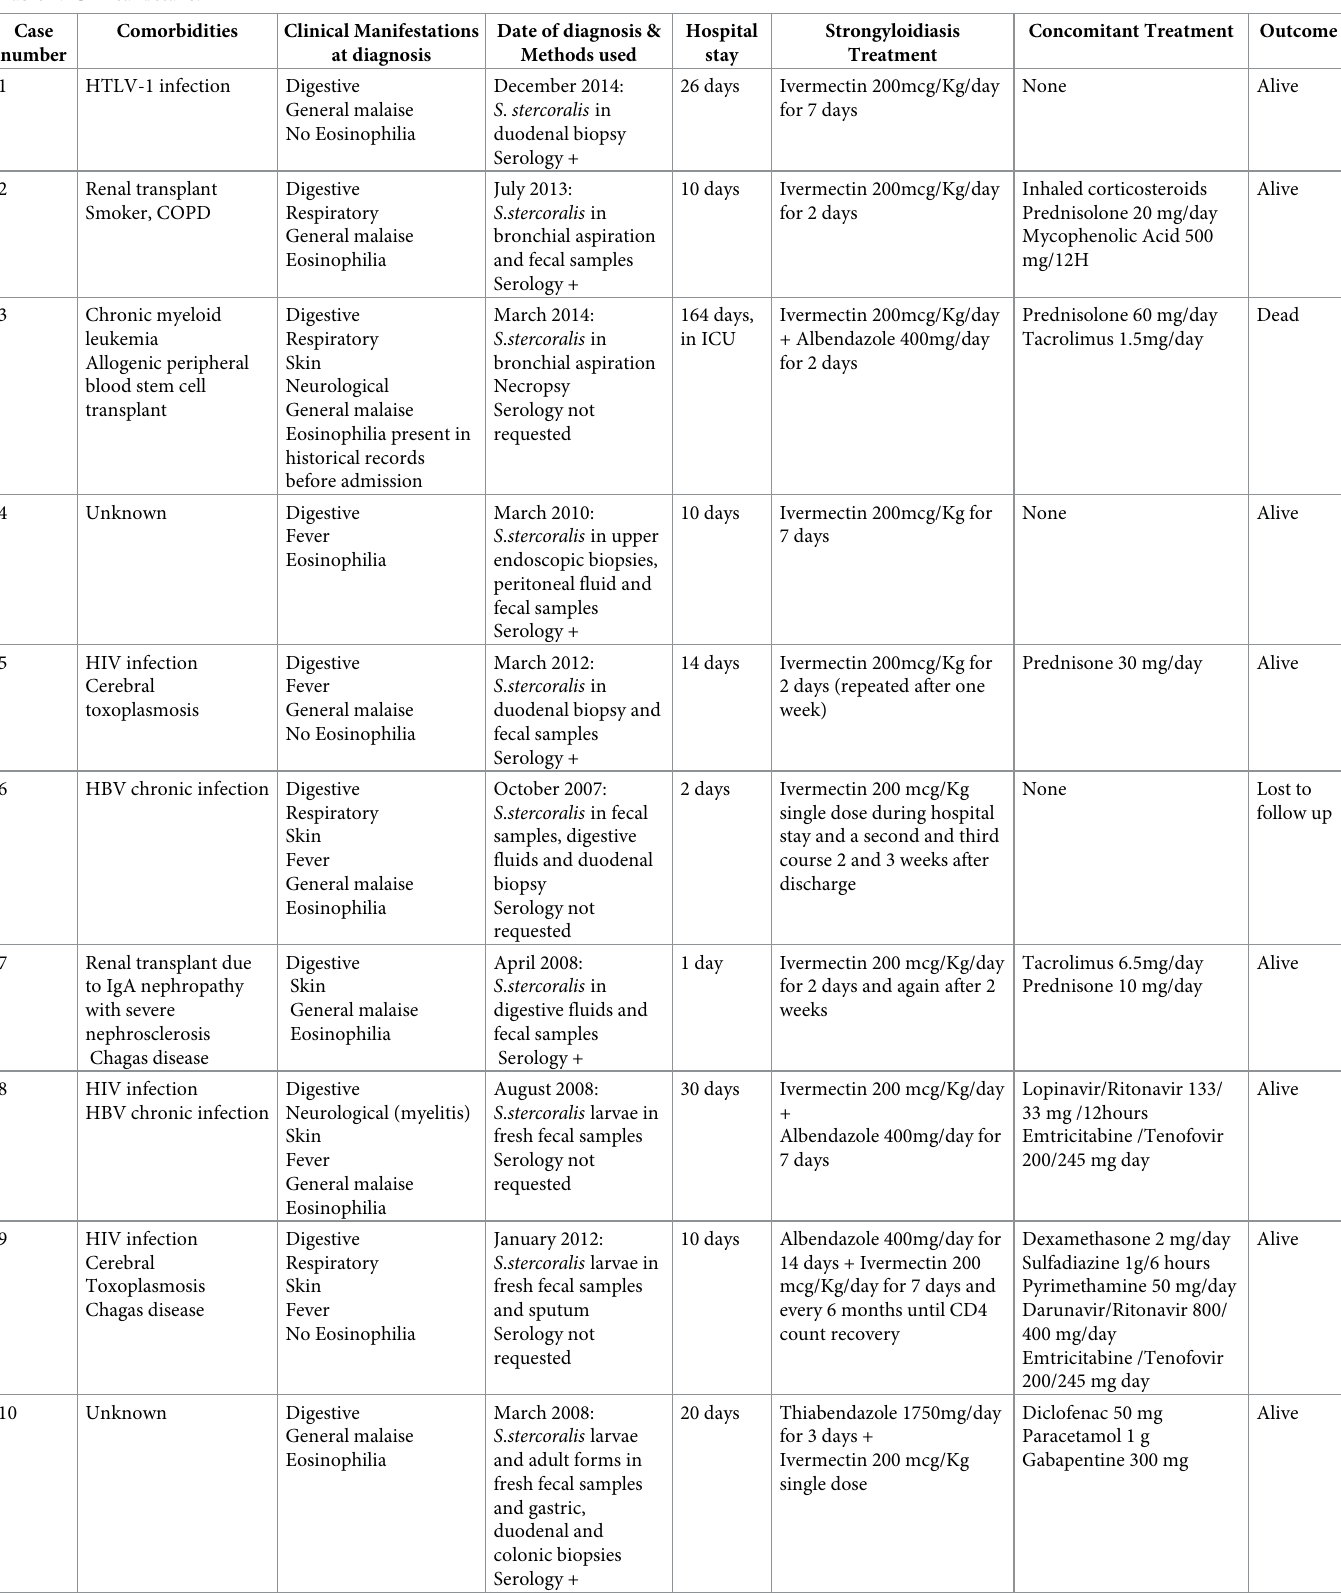
Table 2. Clinical